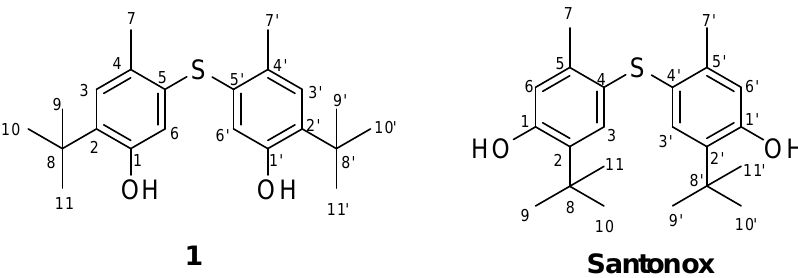
Figure 3. Structures of Compound 1 and Santonox.